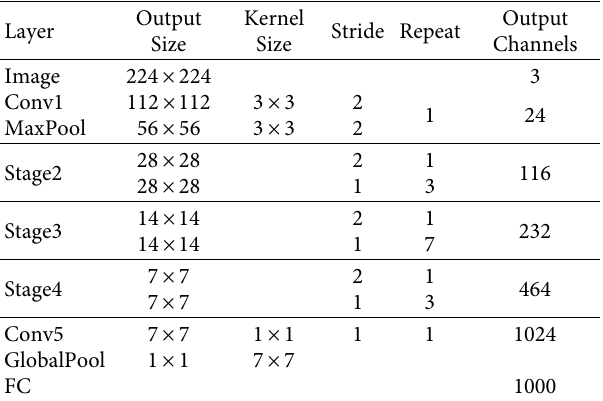
Table 2: Architecture of ShuffleNet-v2